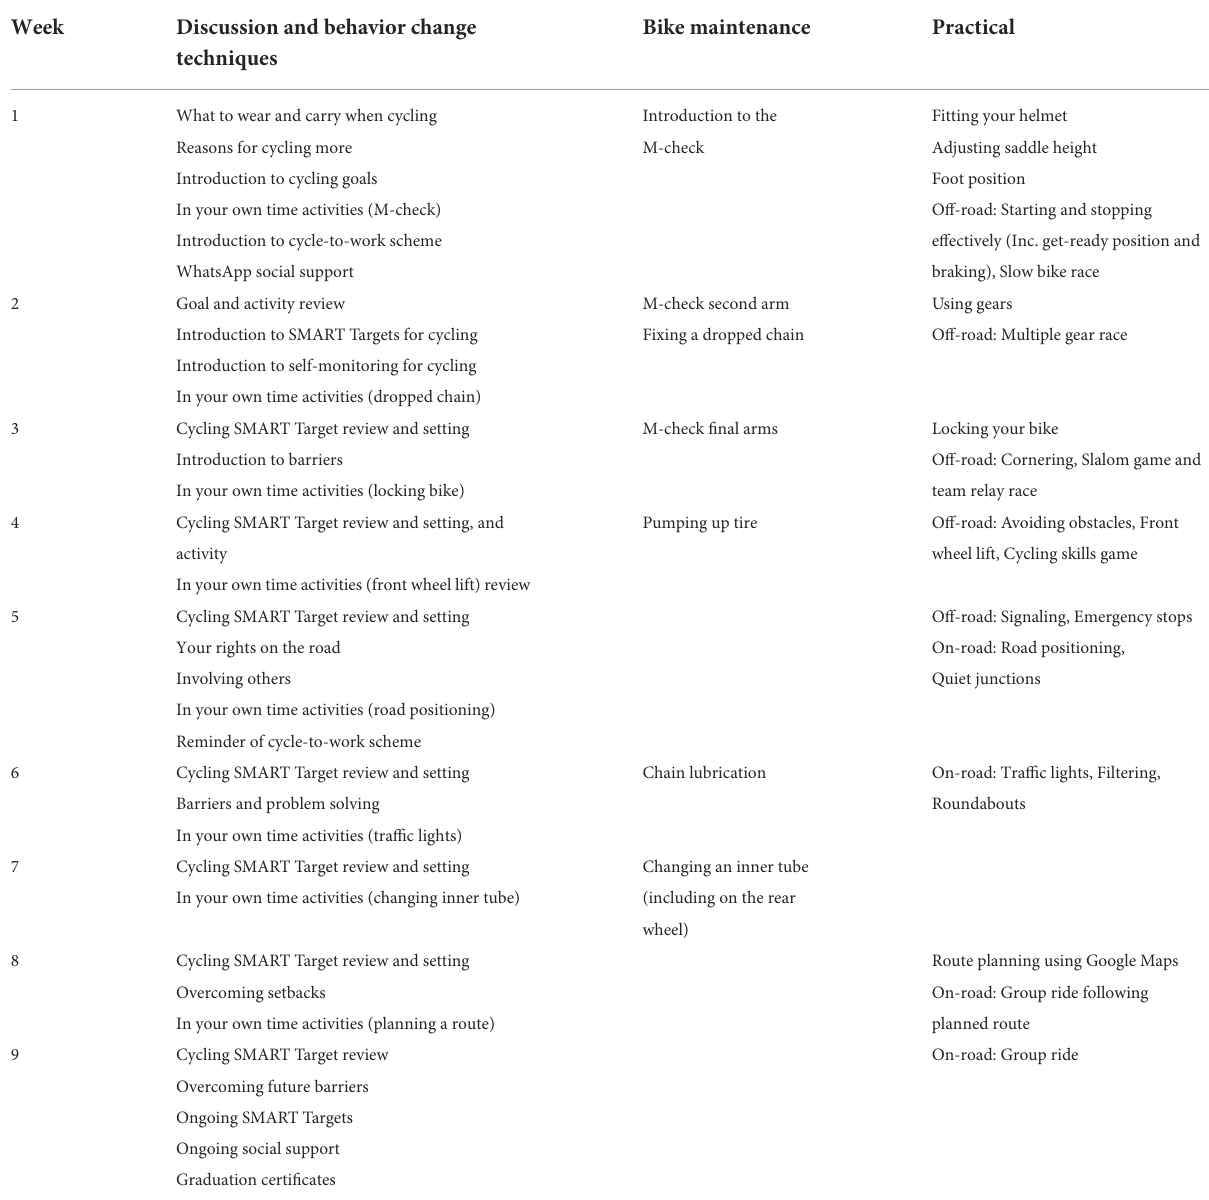
TABLE 8 Final CNP intervention: Summary of key activities for each weekly